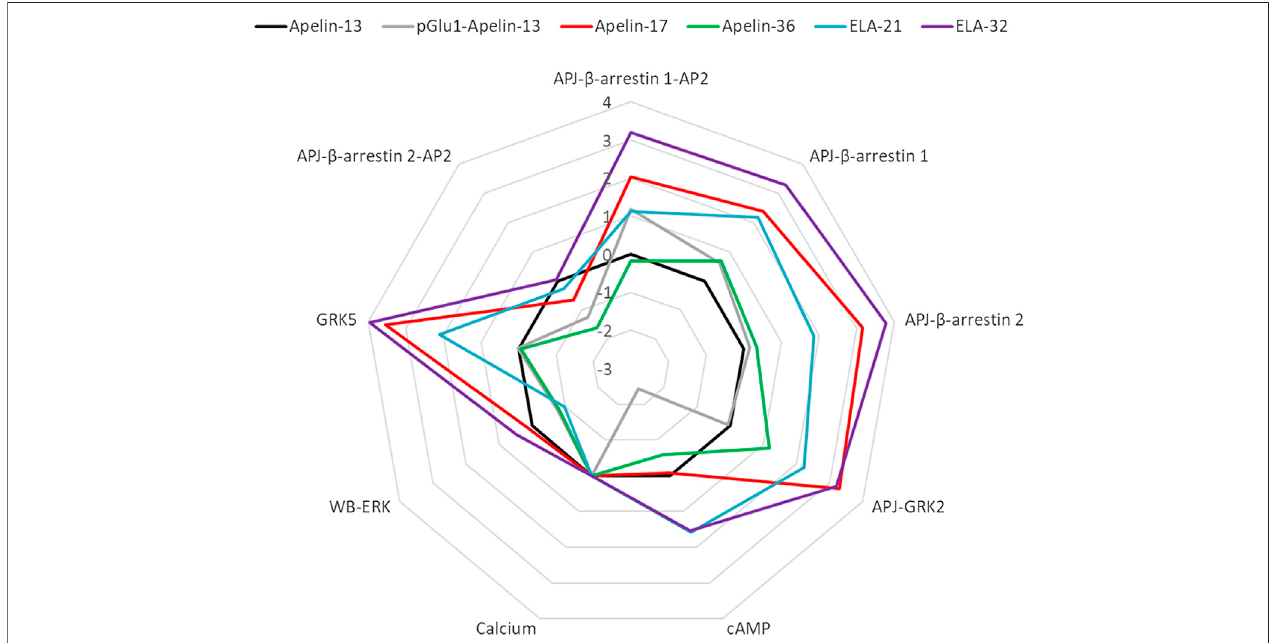
FIGURE10| WebchartofLog(biasfactor)ofthesixpeptideligandsoneight pathways.Webofbiasillustrating distinctionsinthepatternofsignalingofsixpeptide ligands at APJ. The web of bias plots ΔΔ log ( τ /KA) values for each ligand and for every signaling pathway tested.